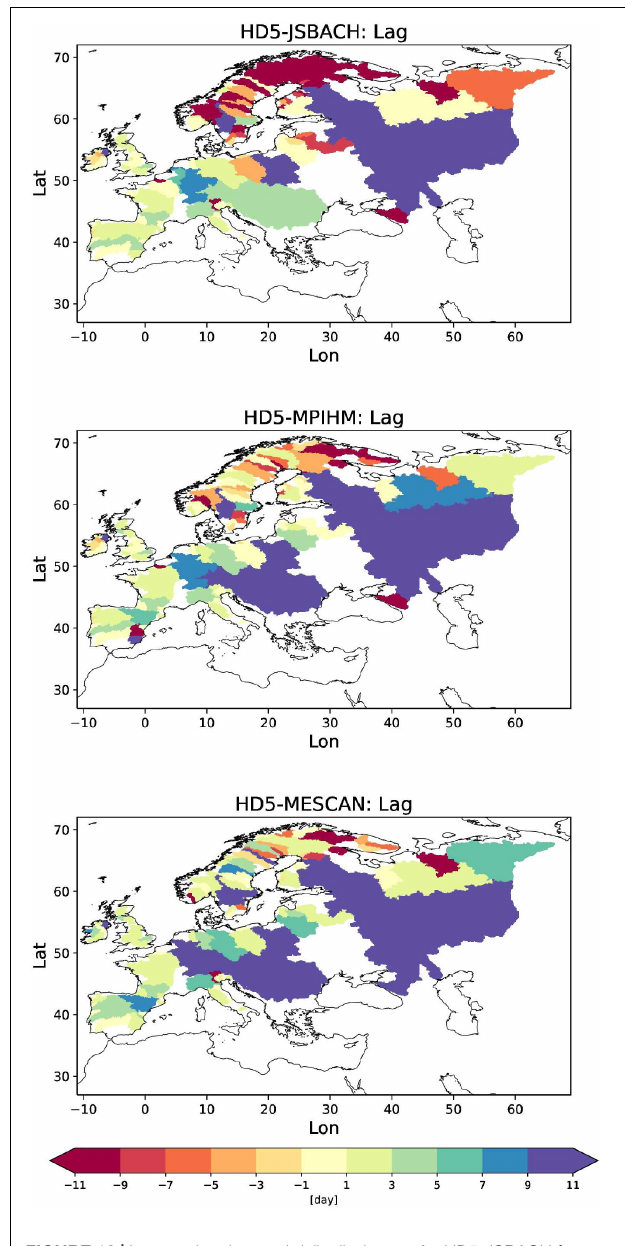
FIGURE 10 | Lags to the observed daily discharges for HD5-JSBACH (upper panel) , HD5-MPIHM (middle panel), and HD5-MESCAN (lower panel) . A positive lag indicates that the simulated discharge is delayed compared to the observed